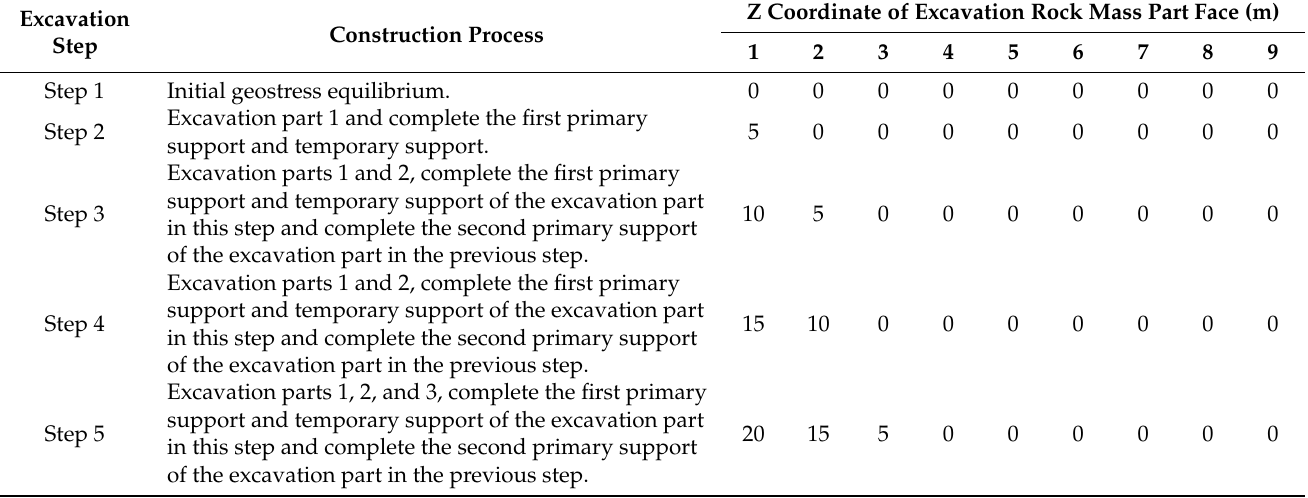
Table 4. Excavation sequence of Condition 1.